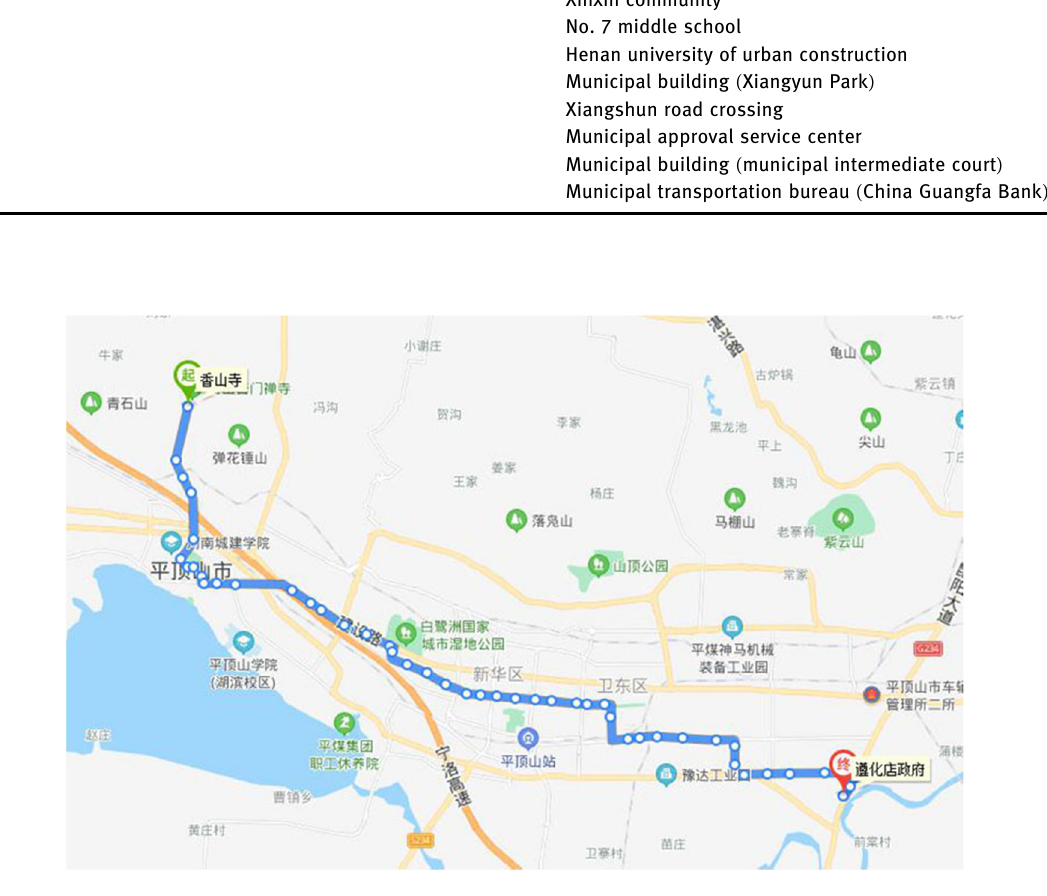
Figure 1: Route of bus No. 16 [ 11 ]